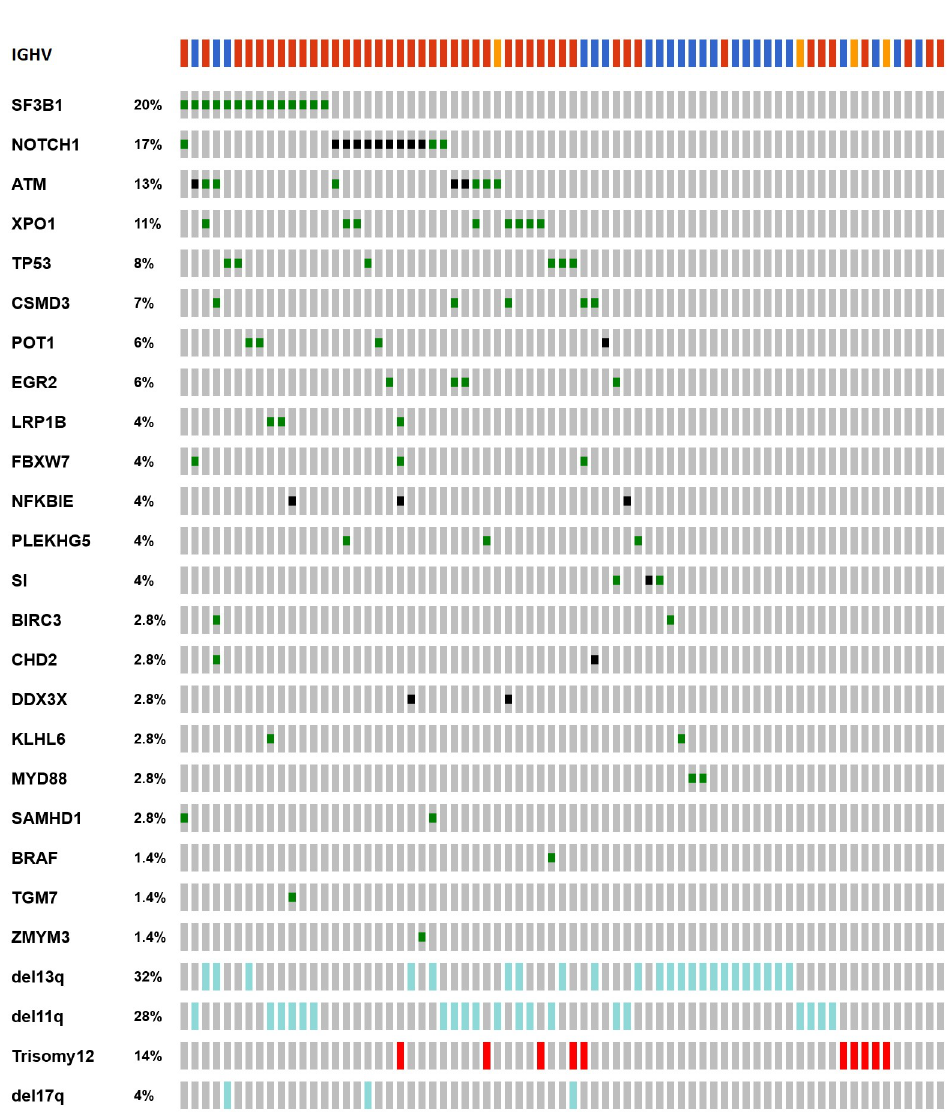
Fig 1. Incidence and distribution of mutations in the 26 analyzed genes and genetic markers in the REM cohort. Rows correspond to sequenced genes and genetic features; columns represent individual patients with CLL. (Figure done with oncoprint tool in cBioPortal). Colour code: IGHV: red, unmutated IGHV, blue: mutated IGHV, orange: no data. Genetic alterations: green, missense mutation; black, truncating mutation; light blue, deletion; red,